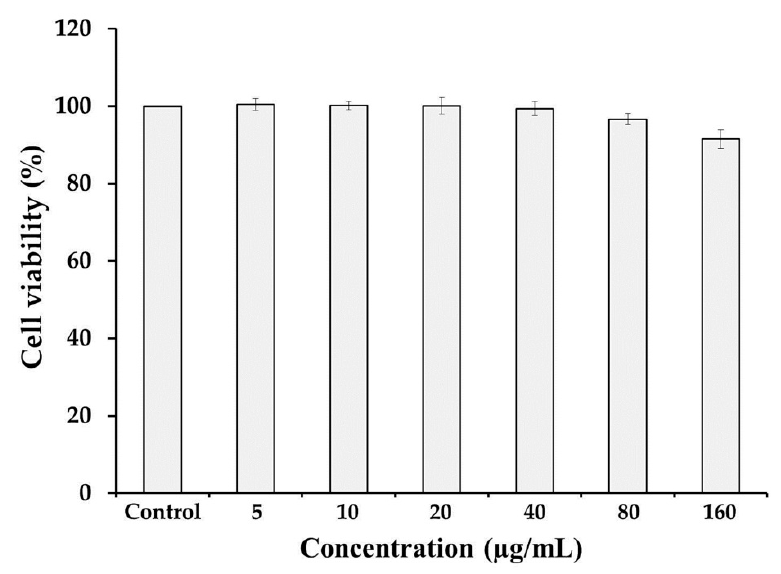
Figure 2. Cell viability of human dermal fibroblast cell lines exposed to astaxanthin at different concentrations for 24 h determined by 3-(4,5-dimethylthiazol-2-yl)-2,5-diphenyltetrazolium bromide (MTT) assay.